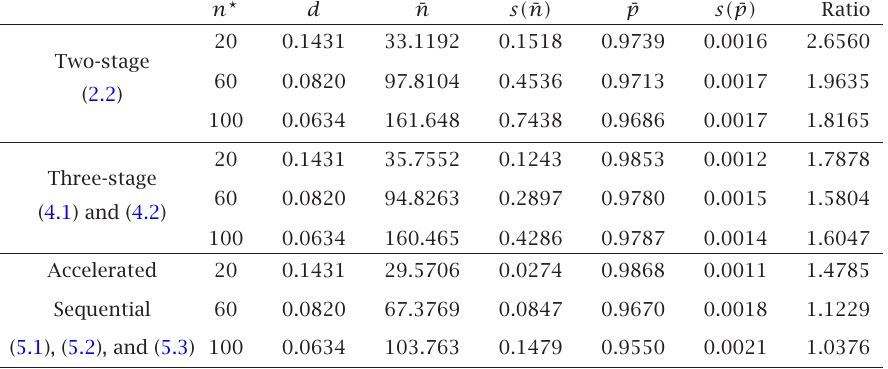
Table 6.2 . Comparisons of the procedures with m = 20 when α = 0 .